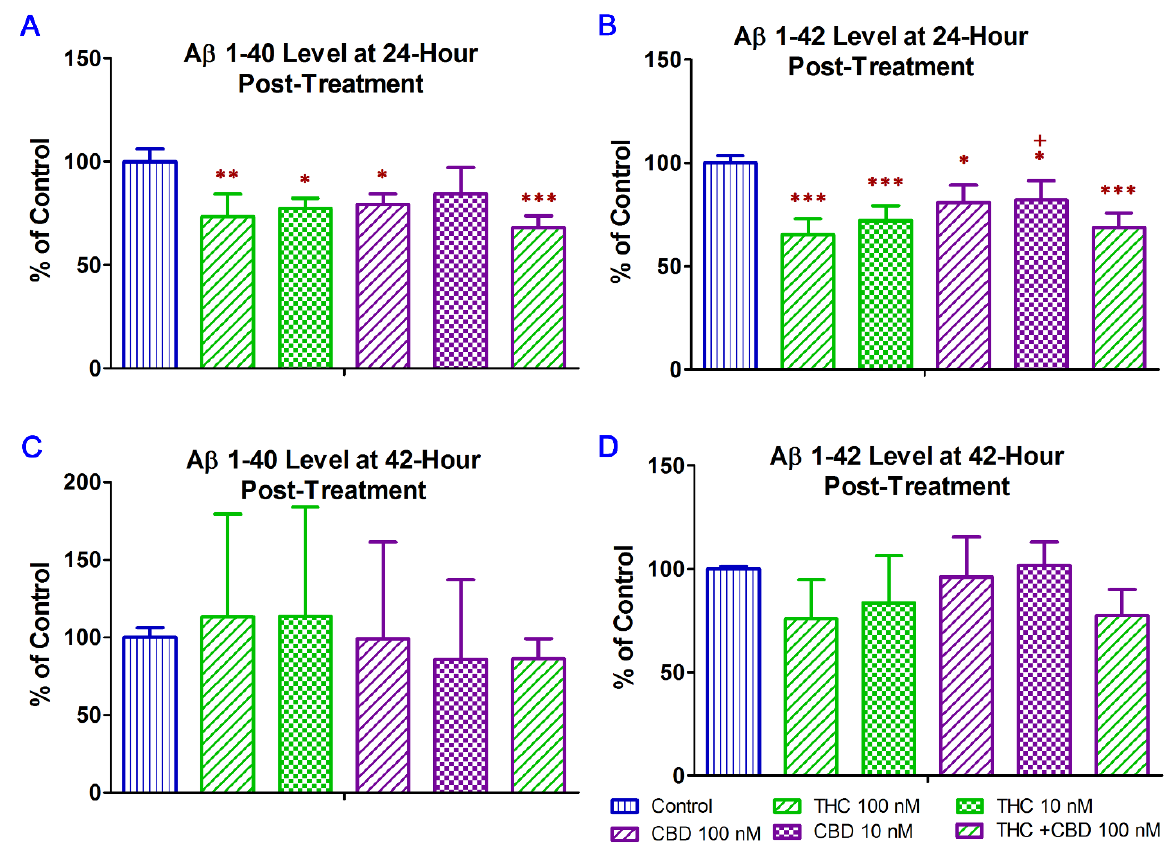
Figure 2. Effect of THC and CBD treatment alone or in combination on A β 1–40 and A β 1–42 production in N2a/APPswe cells at 24 ( A ) for A β 1–40; ( B ) for A β 1–42) and 42 ( C ) for A β 1–40; ( D ) for A β 1–42) hours after the treatment. The production of A β 1–40 and A β 1–42 in the cell culture supernatant was determined by ELISA. After N2a/APPswe cells were treated with THC and CBD alone or in combination for 24 h, A β 1–40 and A β 1–42 levels in the supernatant reduced significantly by 16~32% and 18~35%, respectively, compared with those in the non-treated control samples. No significant changes in the A β 1–40 and A β 1–42 levels in the supernatant were found between the non-treated and treated samples after the 42-h treatment. Data are expressed as mean ± SD ( N = 4). SD is denoted by the error bars. * p < 0.05, ** p < 0.01, and *** p < 0.001 compared with the control group and + p < 0.05 compared with the 100 nM THC treatment group using one-way ANOVA followed by the Tukey–Kramer post hoc multiple comparison test.